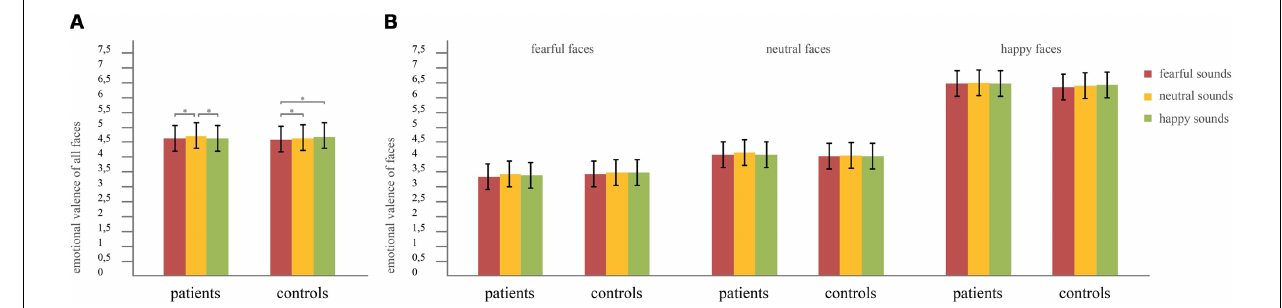
when presented with neutral sounds, while controls rated faces significantly more fearful when presented with fearful sounds than when presented with neutral sounds, but ratings did not differ between the neutral and the happy sound conditions. (B) Mean values of the ratings of fearful, neutral, and happy faces separately. No interaction sound × face × group was found in the MANOVA, therefore no further post hoc tests were calculated.